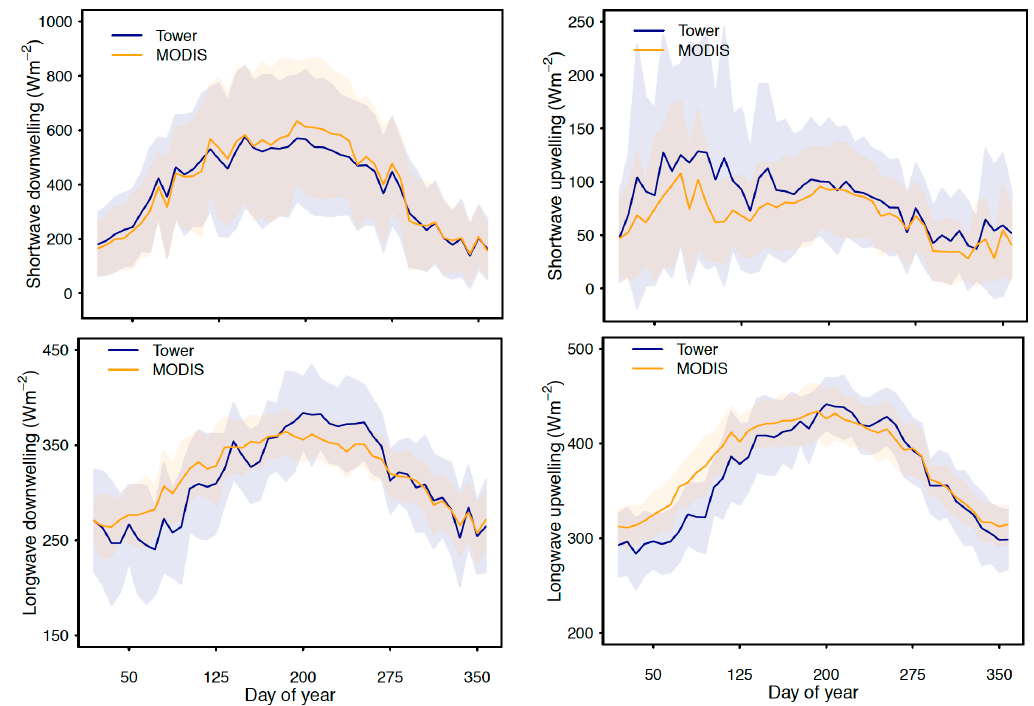
Figure 10. Comparison between the four components of net-radiation from MODIS and corresponding measurements at Terra overpass time at 38 temperate-continental sites. Note that the Y -axis scales are different in different subplots.